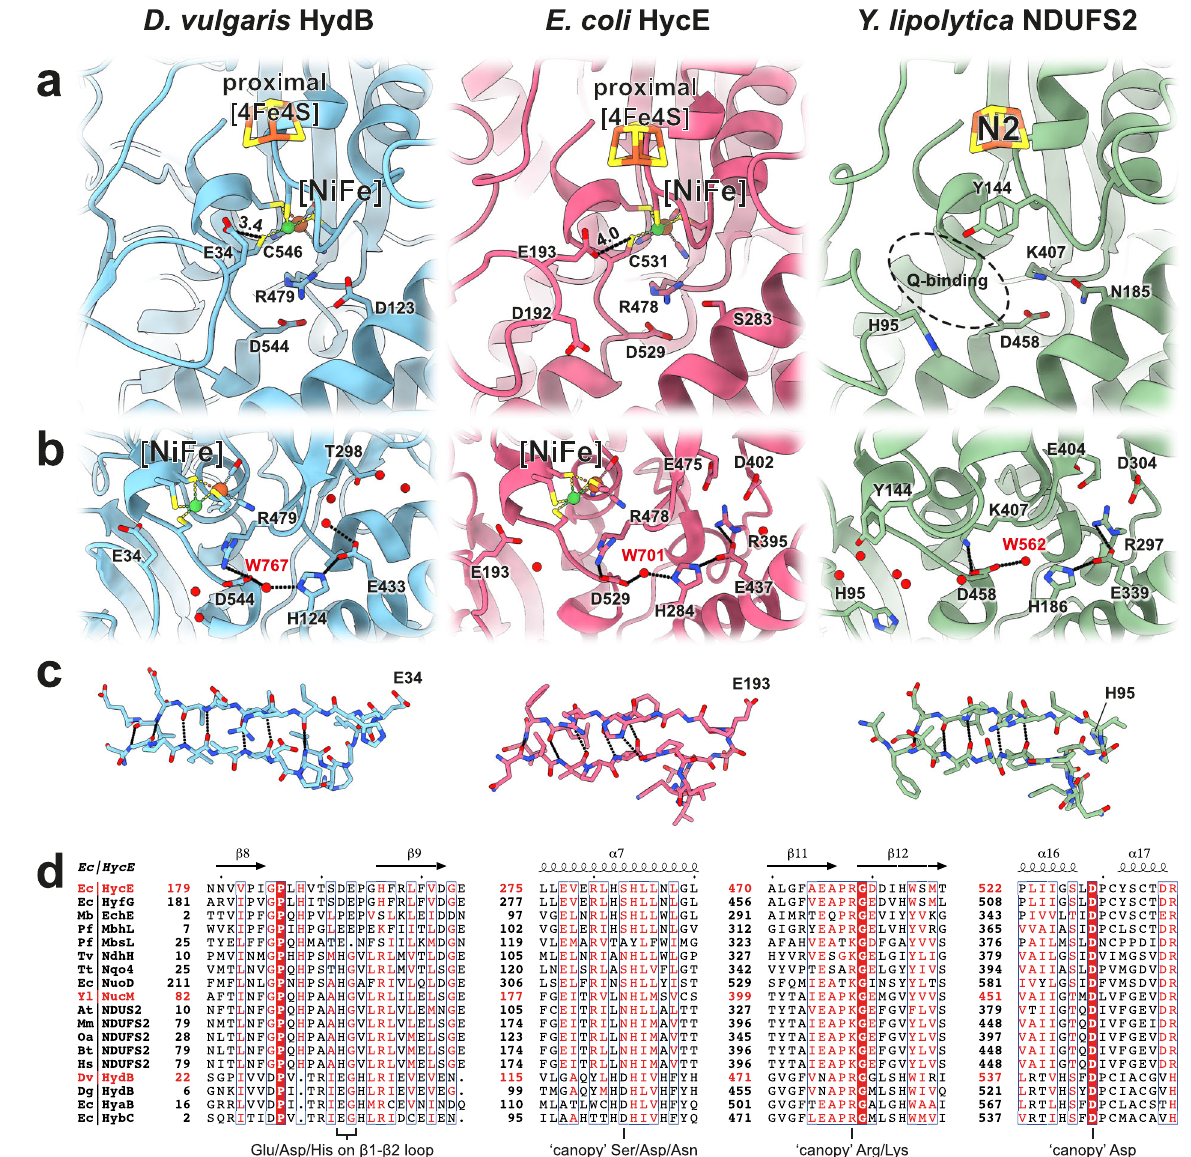
Fig. 5 | Catalytic sites and substrate proton pathways in soluble [NiFe] hydrogenases, FHL and complex I. a Comparison of putative proton-transferring residues in a soluble [NiFe] hydrogenase (PDB 4U9H 56 ), FHL and complex I (PDB 7O71 41 ). Distances between the conserved β 1- β 2 loop glutamate (HydB E34, HycE E193) and the terminal cysteine (HydB C546, HycE C531) are indicated in Å. In complex I the β 1- β 2 loop harbors a conserved histidine (NDUFS2 H95), which is believed to donate a proton for quinone reduction. The canopy residues (HydB R479/D544/D123, HycE R478/D529/S283, NDUFS2 K407/D458/N185) are located in proximity to the active site of the enzymes. b Proton pathways extend from the active site to the bulk via conserved residues (HydB R479/D544/H124/E433, HycE R478/D529/H284/E437/R395, NDUFS2 K407/D458/H186/E339/R297). Select water